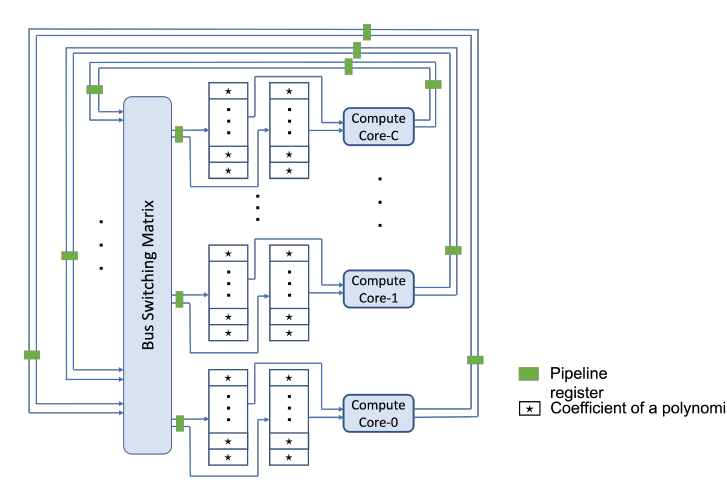
Figure 2: Organization of memory and compute cores for parallel